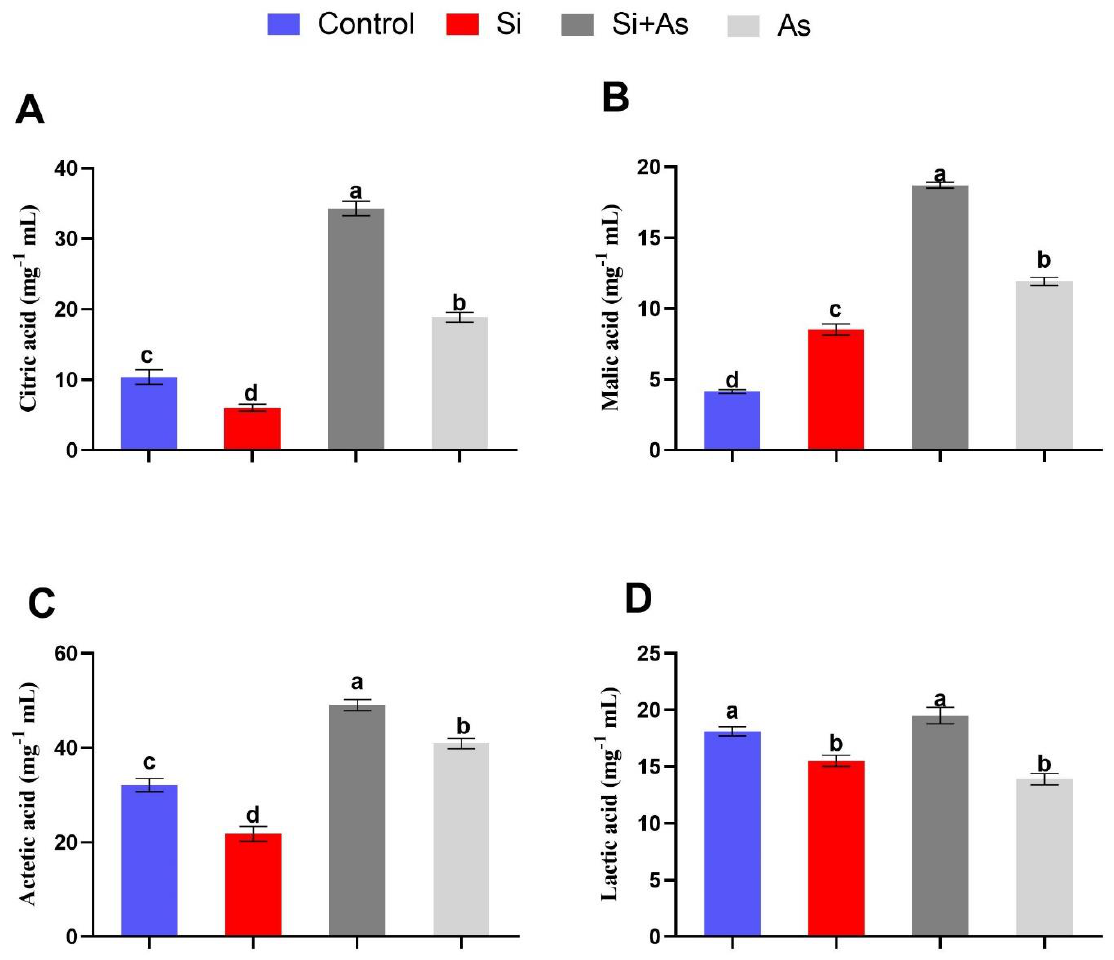
Figure 7. Effects of Si on organic acids regulation. ( A ) Citric acid, ( B ) malic acid, ( C ) acetic acid, and ( D ) lactic acid levels in date palm roots and soil, i.e., treated and non-treated with silicon and arsenic (Si, XSi, Si + As, and As). Data represented as mean (6 replicas) ± shows standard error, symbols denote significant differences among values as determined by Duncan’s multiple range test